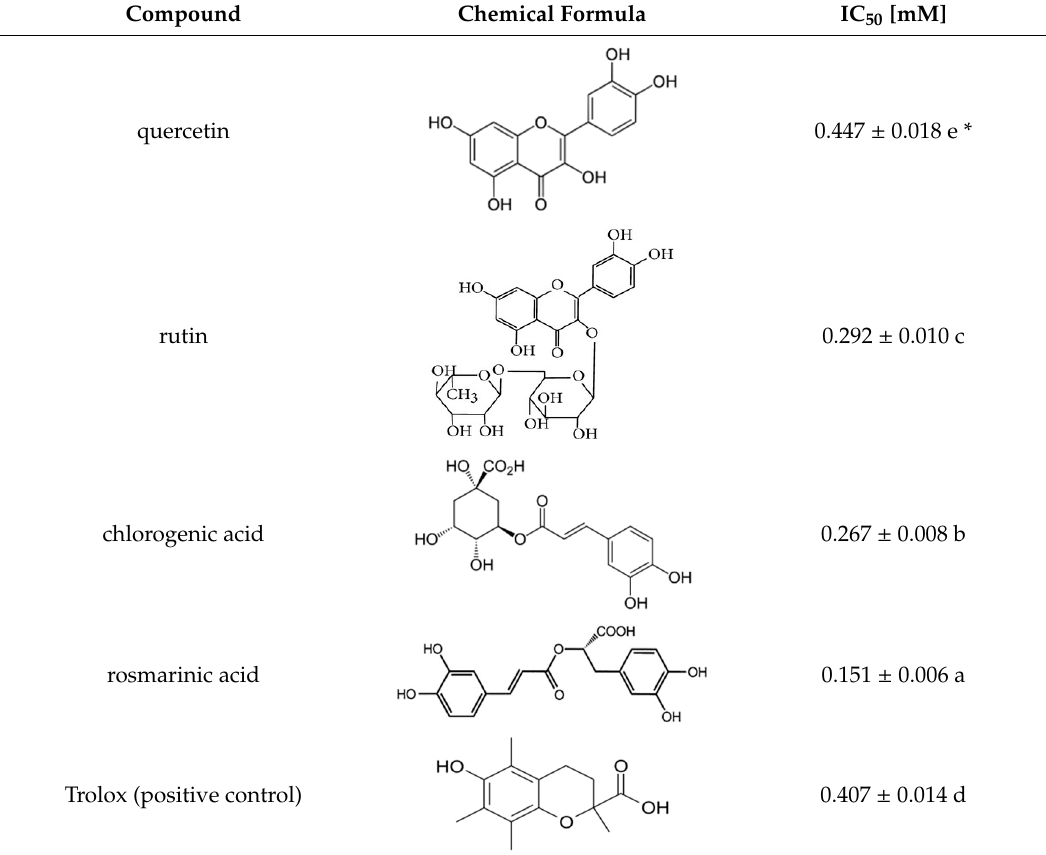
Table 2. Km value, Vmax and content of proteins in thyroid peroxidase (TPO) enzyme solution prepared from porcine thyroid gland, ( n = 9).